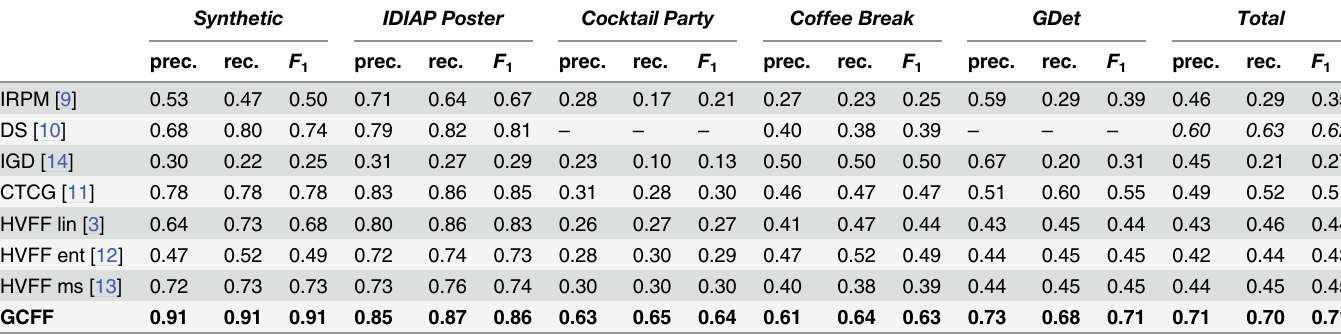
Table 6. Average precision, recall and F 1 scores for all the methods and all the datasets ( T = 1). Please note that DS results are averaged over only 3 datasets and thus cannot be taken into account for a fair comparison.